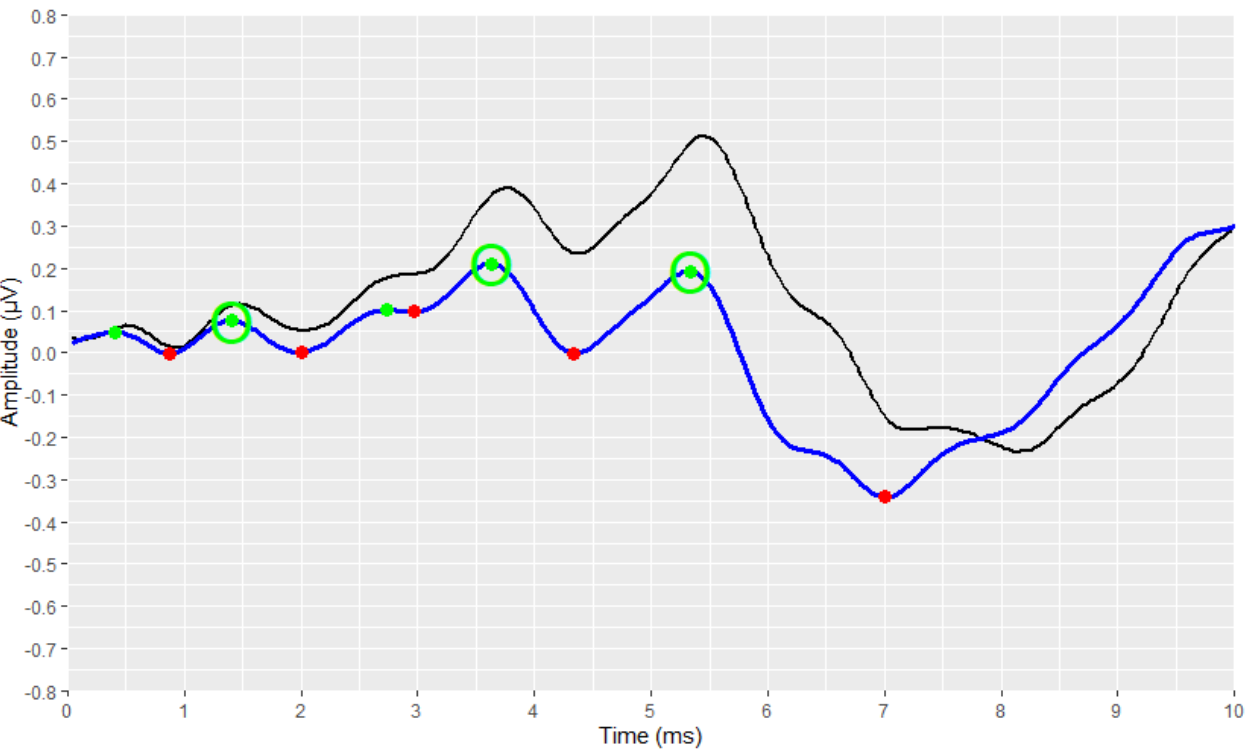
Figure 10. Detection of the ABR signal’s waves of interest as resulting from the implementation of the ABR automated annotation tool.